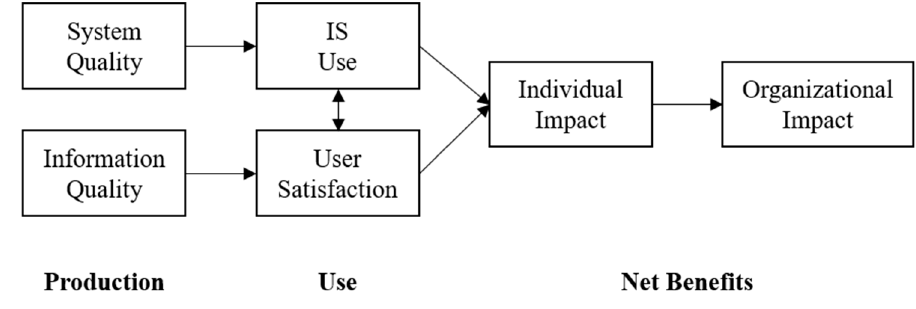
Figure 1. The information systems (IS) success model.